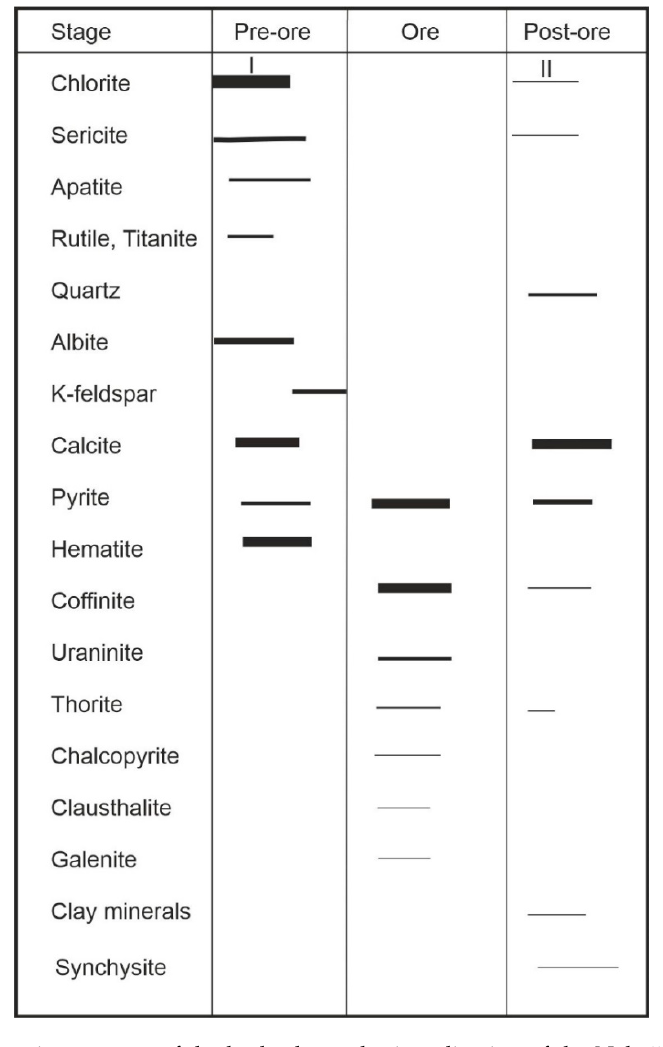
Figure 4. Paragenetic sequence of the hydrothermal mineralization of the Nahošín and Me č ichov uranium deposits, modified from [19].